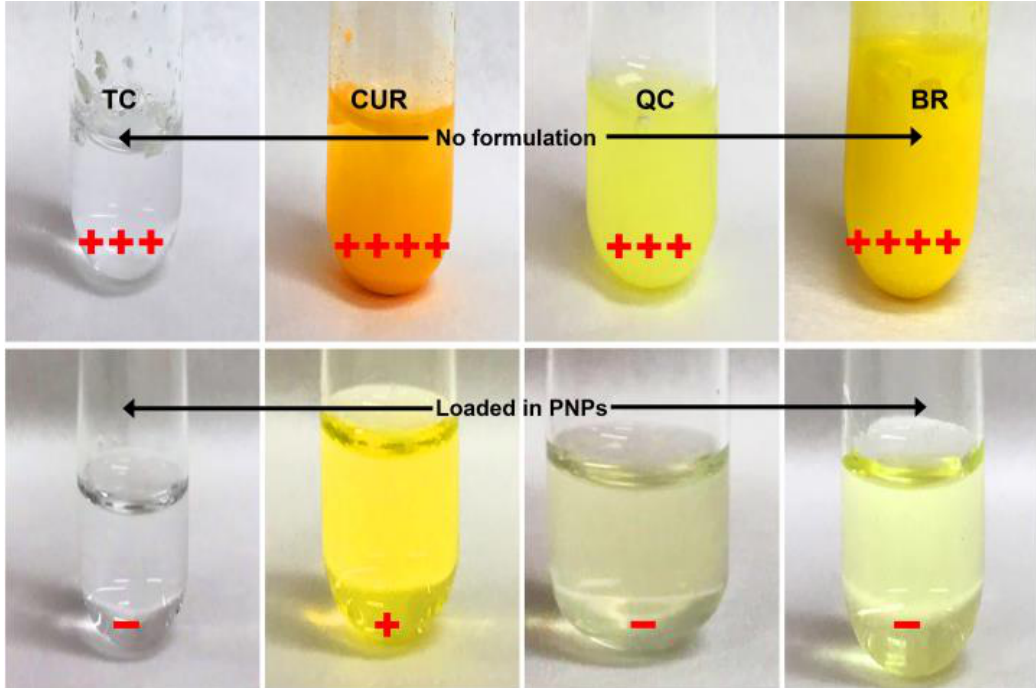
Figure 1. Visual assessment of the dispersibility of unformulated and PNP-formulated SrtAIs TC, CUR, QC, and BR in water at 1 mg/mL. Visual assessment of precipitation is semi-quantitatively reported on each image as: − , no precipitation; +, minor precipitation; ++, some larger aggre- gates/precipitation but mainly translucent; +++, moderate precipitation; and ++++, major precipita- tion.